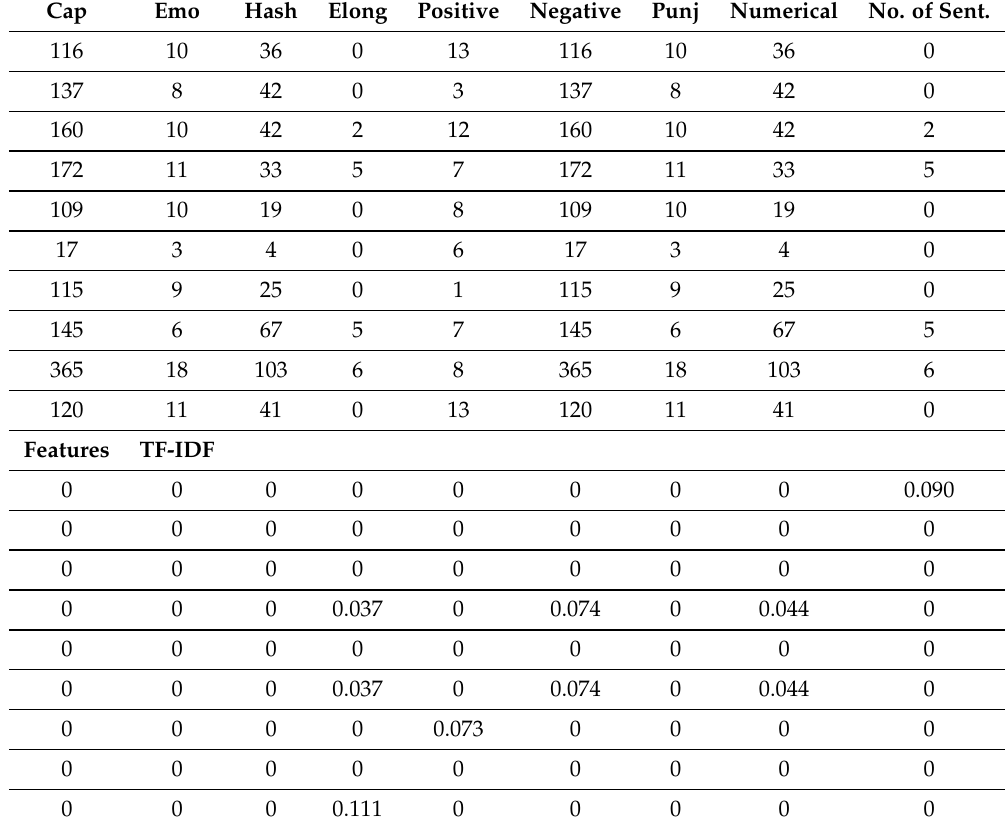
Table 1. Example of feature